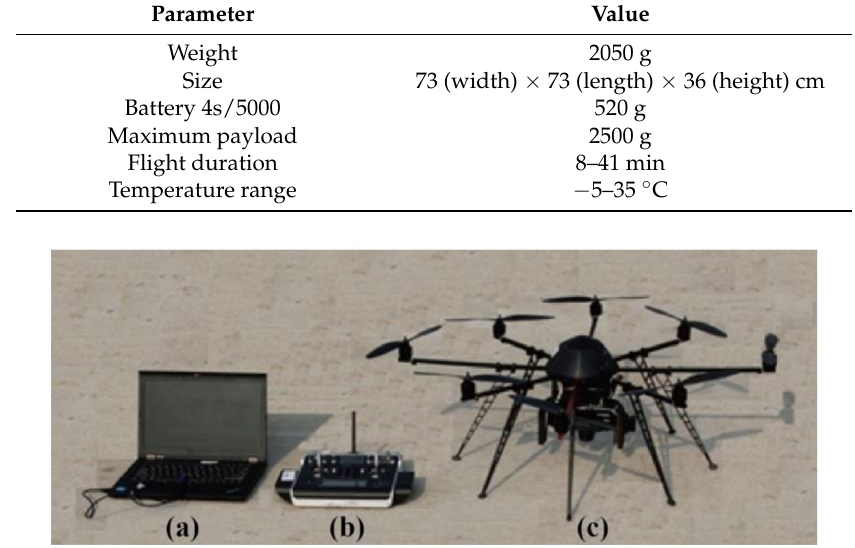
Figure 2. A photo of the UAV system equipped with ( a ) a ThinkPad laptop; ( b ) a Graupner MC-32 control module; and ( c ) an ARF-MikroKopter